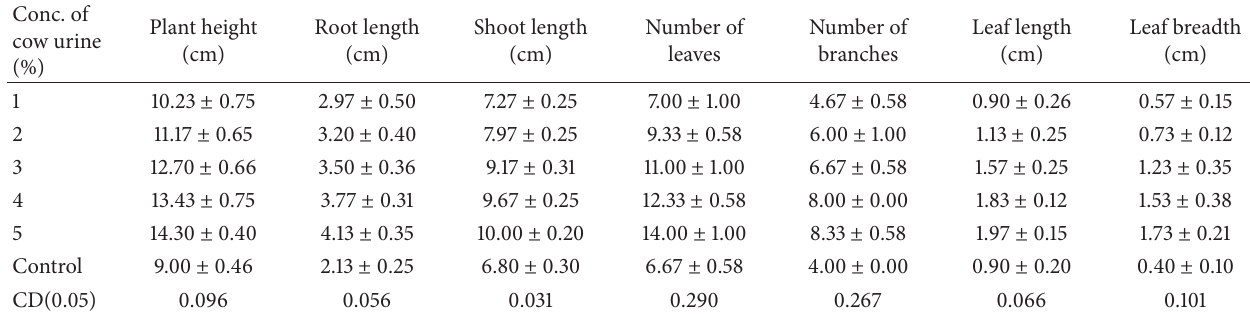
Table 2: Effect of cow urine on exomorphological characters of Trigonella foenum-graecum (Methi) by pot culture experiment after 25 days. Conc.